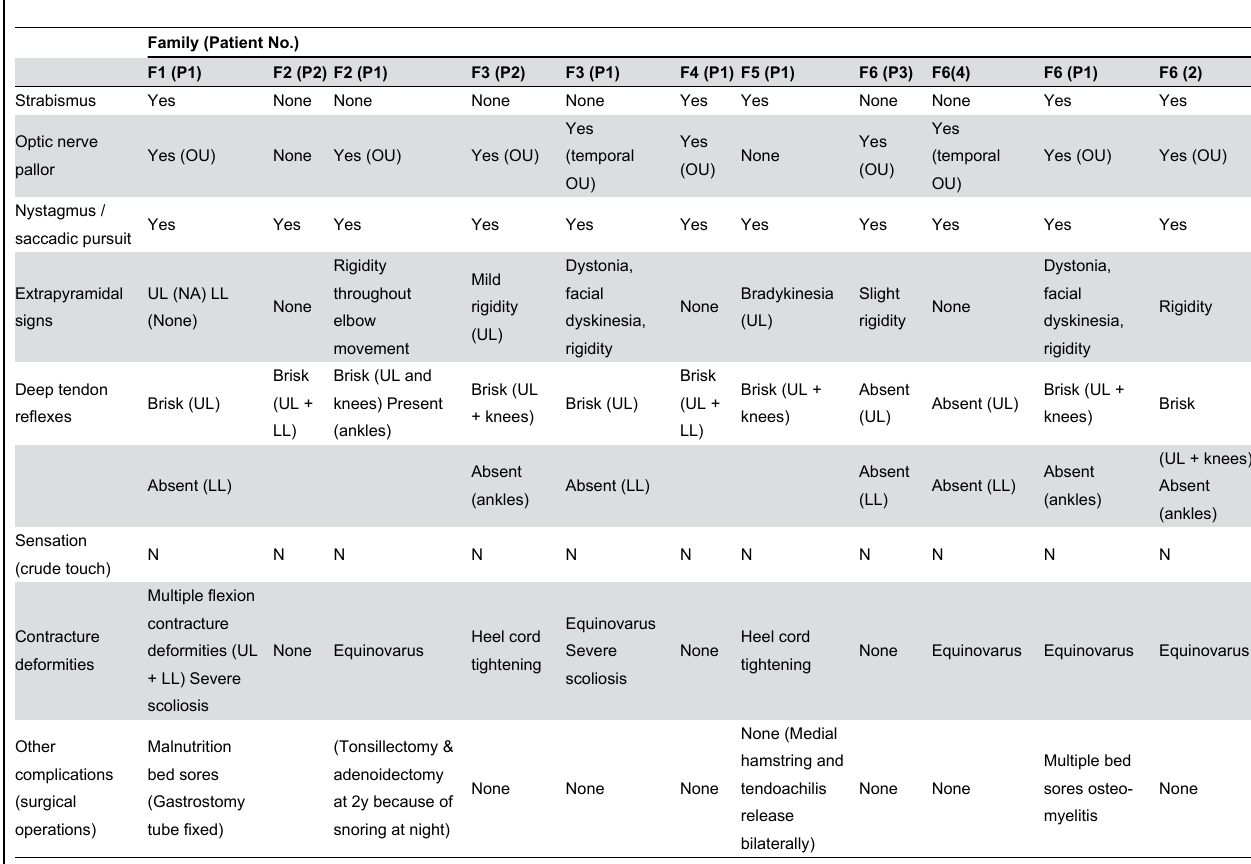
Table 2. Clinical features of 11 patients with PLA2G6 gene mutations.